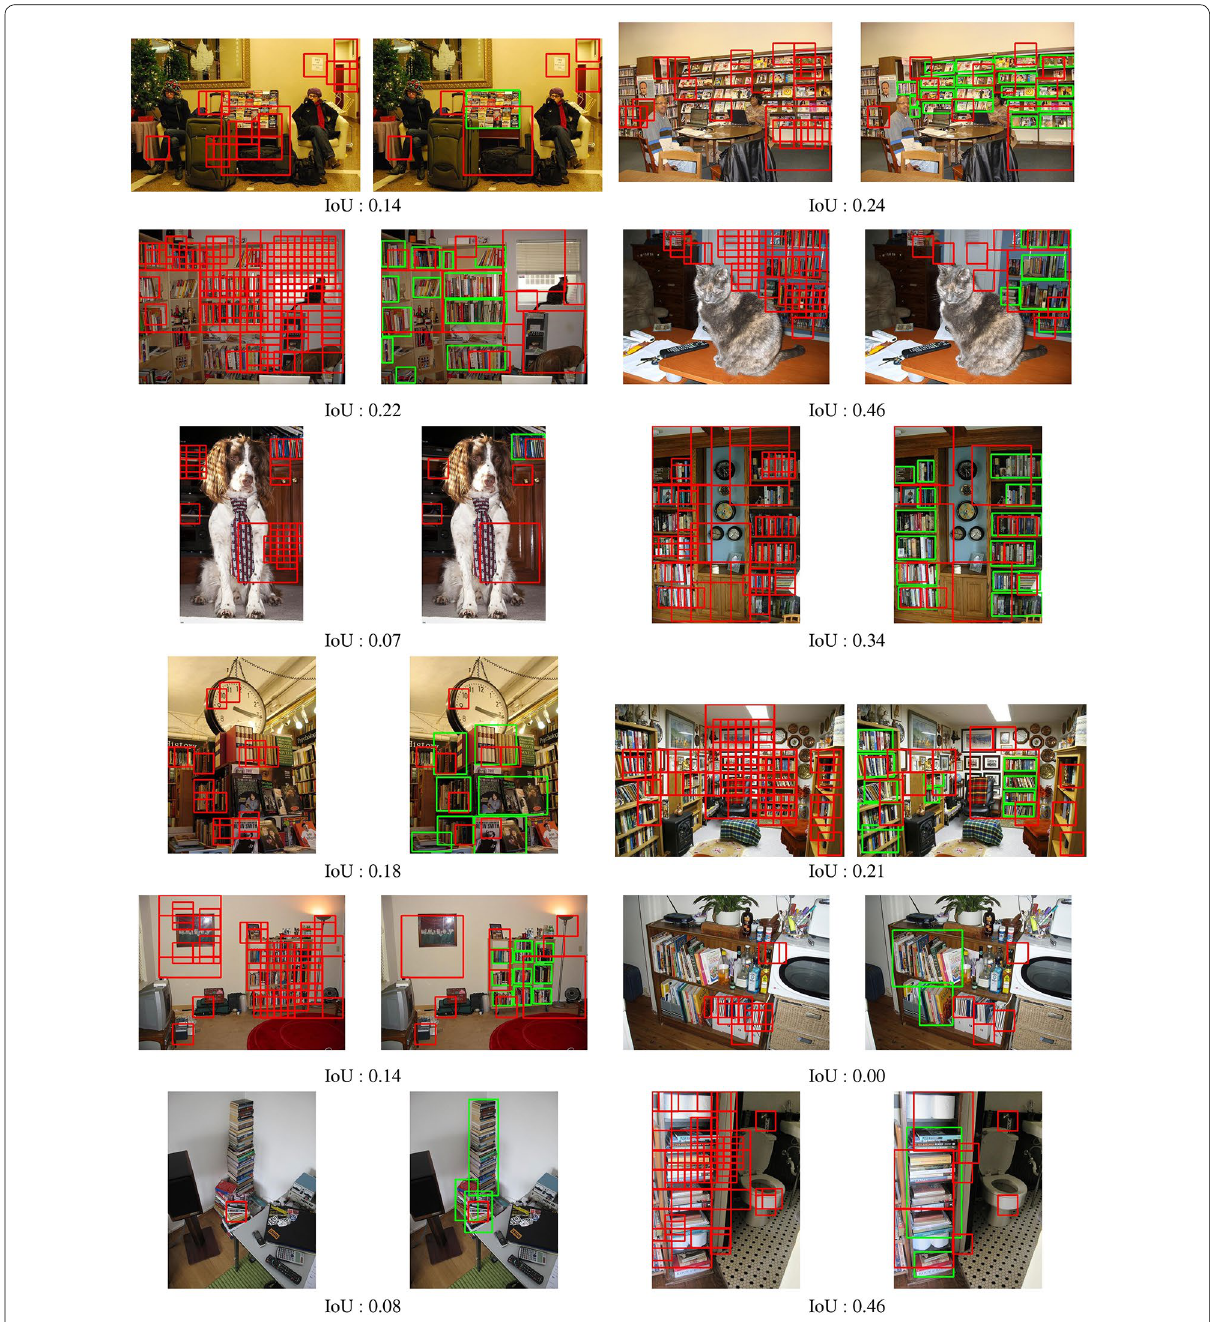
Fig. 22 Extraction examples by the baseline method (2). For each pair, the left side is the extraction result before NMS and the right side is the extraction result after NMS (red BB: predicted, green BB: